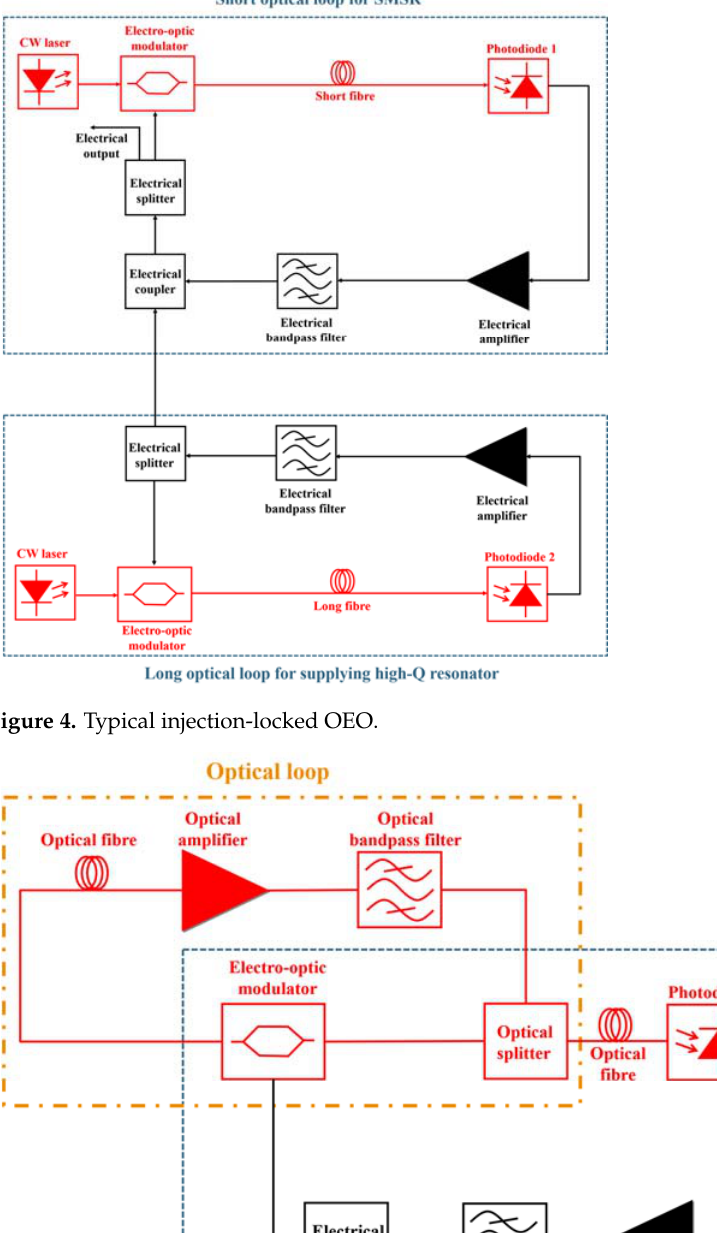
Figure 6. OEO with a feedback-control loop In the feedback control loop, the frequency discriminator controls the temperature of the laser by measuring the refractive index of the optical fiber. A proportional–integral (PI) controller is used to control the temperature of the laser. Using the feedback control